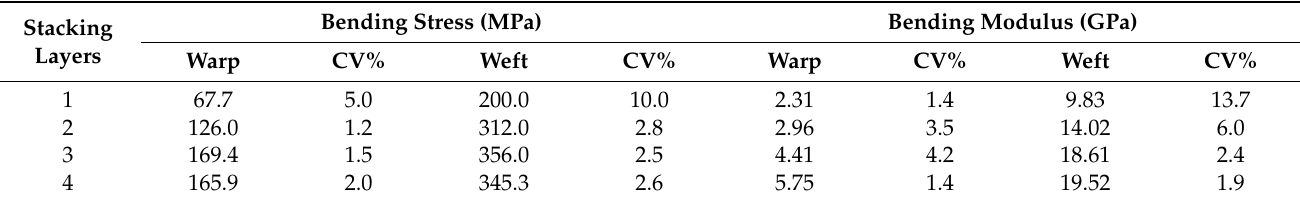
Table 3. The bending properties of materials with different stacking